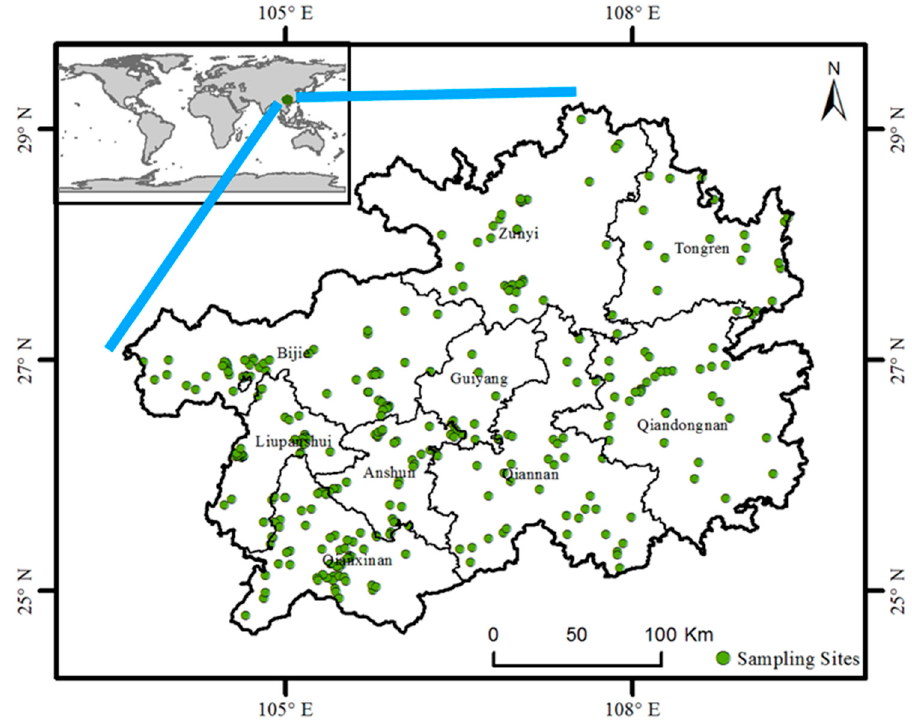
Figure 1. Distribution of the sampling sites in Guizhou Province, Southwest China. The geographic coordinate system of the map is the China Geodetic Coordinate System 2000. Overall, 373 sampling sites, covering nearly all counties of Guizhou Province, were established from July to October in 2021. Within each sampling site, 20 sampling plots (1 × 1 m in size and well separated from each other) were surveyed to determine the plant community composition. At the same time, within each site, three sampling plots (1 × 1 m in size and well separated from each other) were established, and their numbers of species, average plant height, plant cover, and plant biomass for both invasive and non- invasive species were determined. The aboveground vegetation in each plot was collected by species. Plant samples were dried for 90 h at a temperature of 60 ◦ C and weighed to determine aboveground plant biomass. The publications “Alien invasive plants in Chinese grassland” [32], “Invasive alien species of China” (website: http://www.iplant.cn/ias/, accessed on 1 January 2022), and “The checklist of the Chinese invasive plants” [30,31] were used to determine whether a plant was an invasive plant. The invasion levels of each plant species were classified according to previous publications [30,31], using the following five levels: 1, malignant invasive species, that cause malignant economic and ecological damage at a national scale and affect more than one geographical region; 2, seriously invasive species, that cause serious economic and ecological damage at a national scale and affect more than one geographical region; 3, local invasive species, that cause local economic and ecological damage within one or more geographical regions but not nationwide; 4, general invasive species, that will not cause serious or obvious economic and ecological damage based on their biological and ecological characteristics and will most likely not cause new invasions; 5, species requiring further observation; these are newly found, newly reported, or poorly understood species whose invasion trends require further